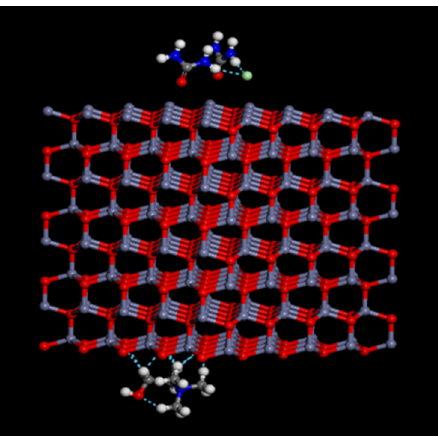
Figure 8. Molecular structure diagram of the ChCl-urea DES.